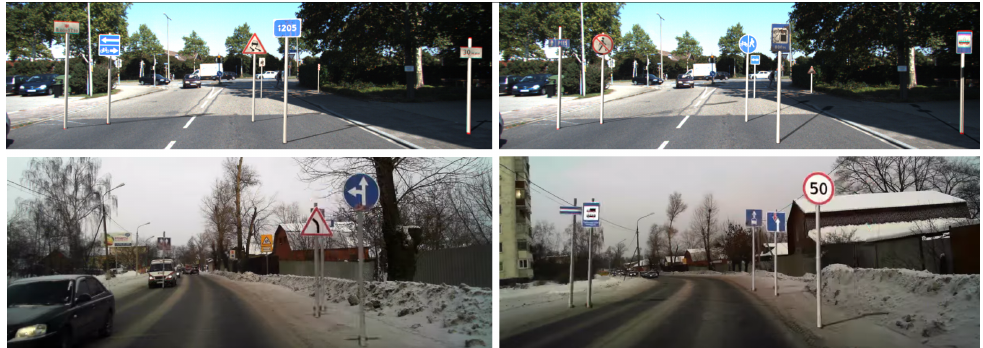
Figure 7. Examples of augmentation road signs in KITTI [13] ( top line ) and RTSD [37] ( bottom line ).